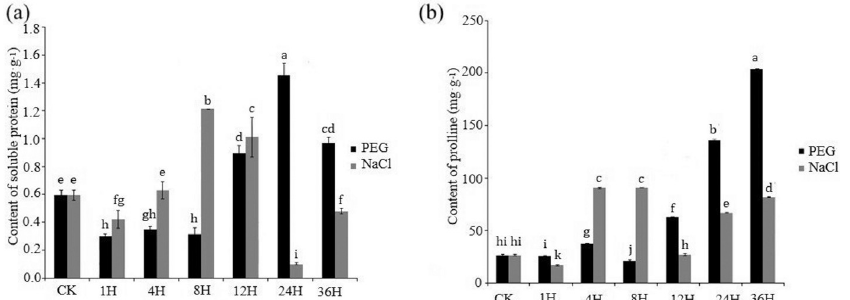
Fig 5. Effect of PEG and salt (250mMNaCl) treatments on the soluble protein (a) and proline (b) content in leaves of grape (Vitis vinifera). To visualize the relative expression levels data are presented as the mean fold changes between treated and control samples at each time point ± standard deviations